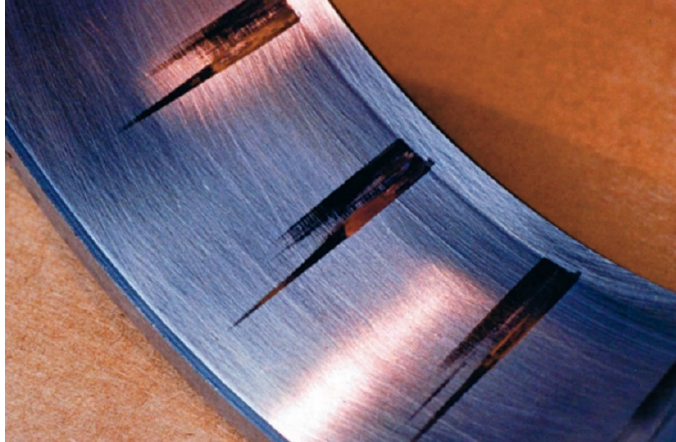
Figure 13. False Brinelling formed on bearings due to localised indentations from contacting materials during relative motion [93]. Reprinted with permission from [93]; 2004 Tribology Lubrication Technology.